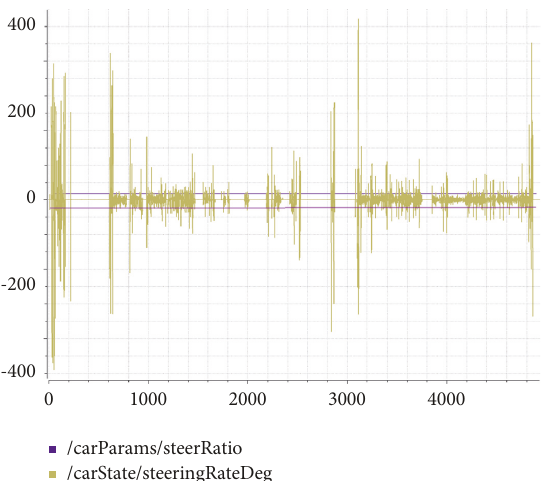
Figure 33: T1N1 steering degrees.